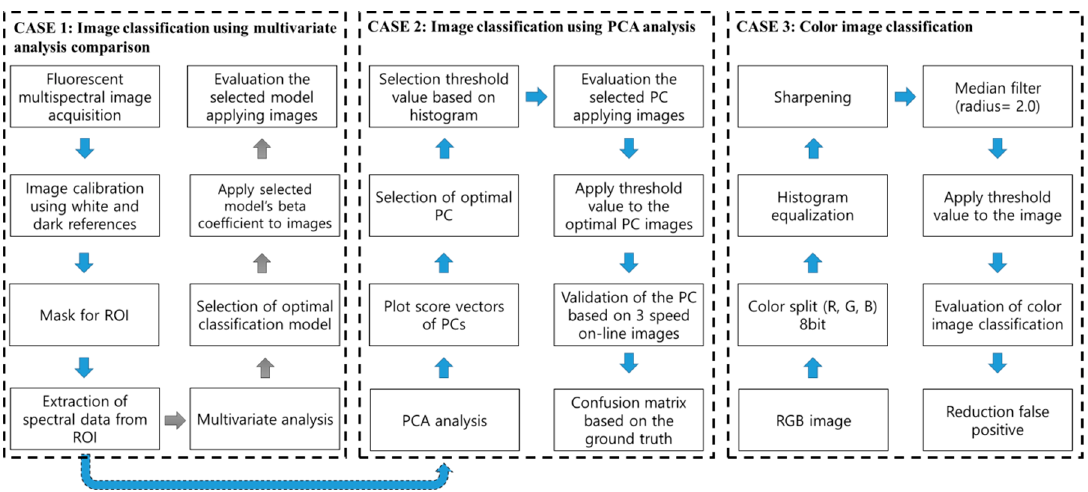
Figure 3. Schematic flowchart for multispectral fluorescence image acquisition and image classification. CASE1 shows data acquisition and spectral classification using multivariate analysis and CASE2 shows image classification based on the optimal principal component (PC). CASE3 is for color image classification.